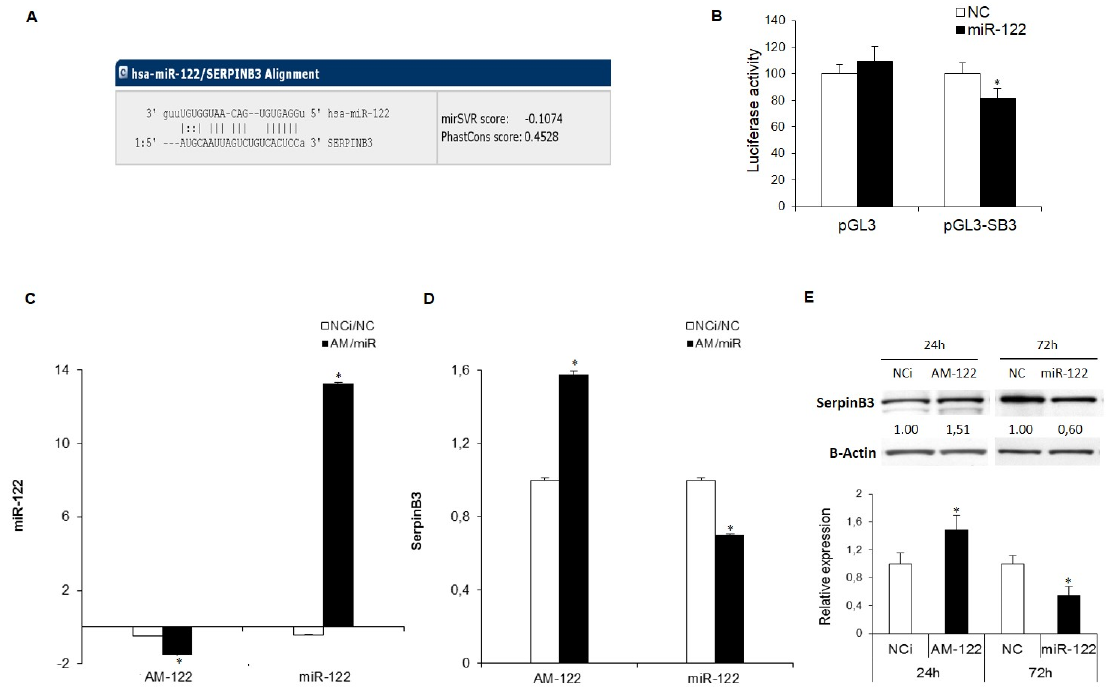
Figure 1. (A) miR-122 binding site in the SerpinB3 3’untranslated region (3’UTR) as reported by the TargetScan algorithm. (B) Dual-luciferase assay in HepG2 cells. The SerpinB3 3’UTR-containing vector was co-transfected with miR-122 or negative control (NC). MiR-122 overexpression determined a decrease of the reporter gene activity in pGL3-SerpinB3 co-transfected HepG2 cells. (C) qPCR analysis of miR-122 levels following miR-122 inhibitor (AM-122) or miR-122 mimic transfection in HepG2 cells stably overexpressing SerpinB3 (HepG2/SerpinB3) with respect to controls. U6RNA was used as housekeeping gene. Y-axis reports 2 − ∆∆ Ct levels expressed in logarithmic form. ( D , E ) qPCR and Western blot analysis of SerpinB3 in transfected HepG2/SerpinB3 cells. β -Actin was used as housekeeping gene. Y-axis reports 2 − ∆∆ Ct levels. NCi: miRNA inhibitor negative control; NC: miRNA precursor negative control. (* p < 0.05). Data shown are representative results of at least three independent experiments.